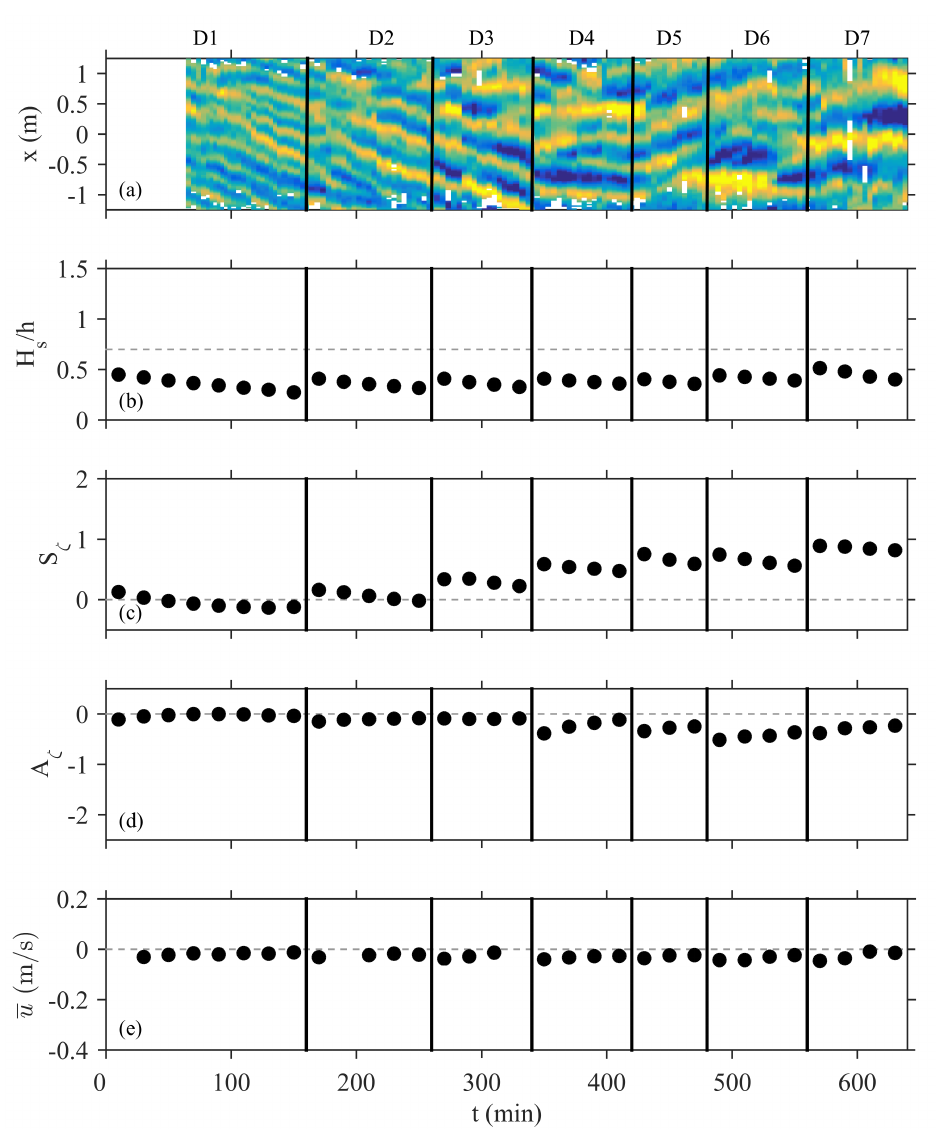
Figure 11. ( a ) Time-space diagram of wave-ripple induced bed variability beneath the sonar during series D. Warm (yellow) colours are ripple crests, cold (blue) colours are ripple troughs. The colors range from − 0 . 05 to 0 . 05 m. The cross-shore coordinate is relative to the sonar, with x = 0 vertically below the sonar, and with positive x onshore. The local x = 0 m corresponds to x = 63 . 1 m in Figure 1. Time series of ( b ) the relative wave height H /h , ( c ) skewness S , ( d ) asymmetry A and ( e ) the mean cross-shore flow u . In ( b )–( e ) s ζ ζ the limits of the vertical axis were set to equal to the range in the entire data set, see Figure 4. H /h , S and A were measured at x = 62 . 5 m, u at x = 65 m. The dashed line in ( b ) marks s ζ ζ /h transition between non-breaking and breaking the approximate H s